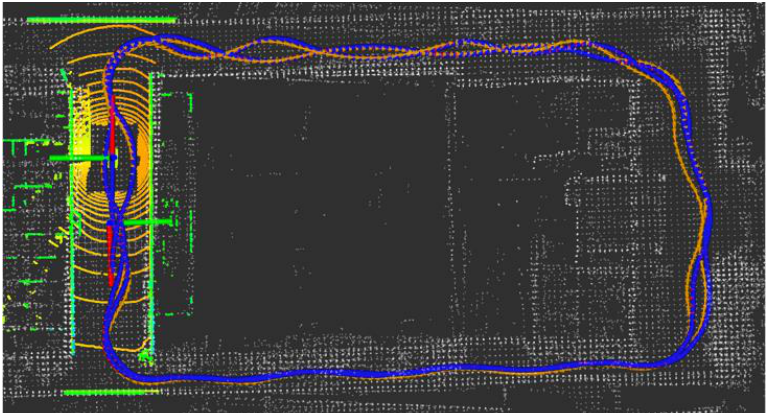
Figure 30. Field test NO.4. Two laps under curve driving scenario localization test trajectory com- parison. The comparison of fused trajectory with groundtruth. Figure 31. Field test NO.4. Two laps under curve driving scenario localization error in longitudinal, lateral, and altitude directions, respectively; the localization error is at the centimeter level.